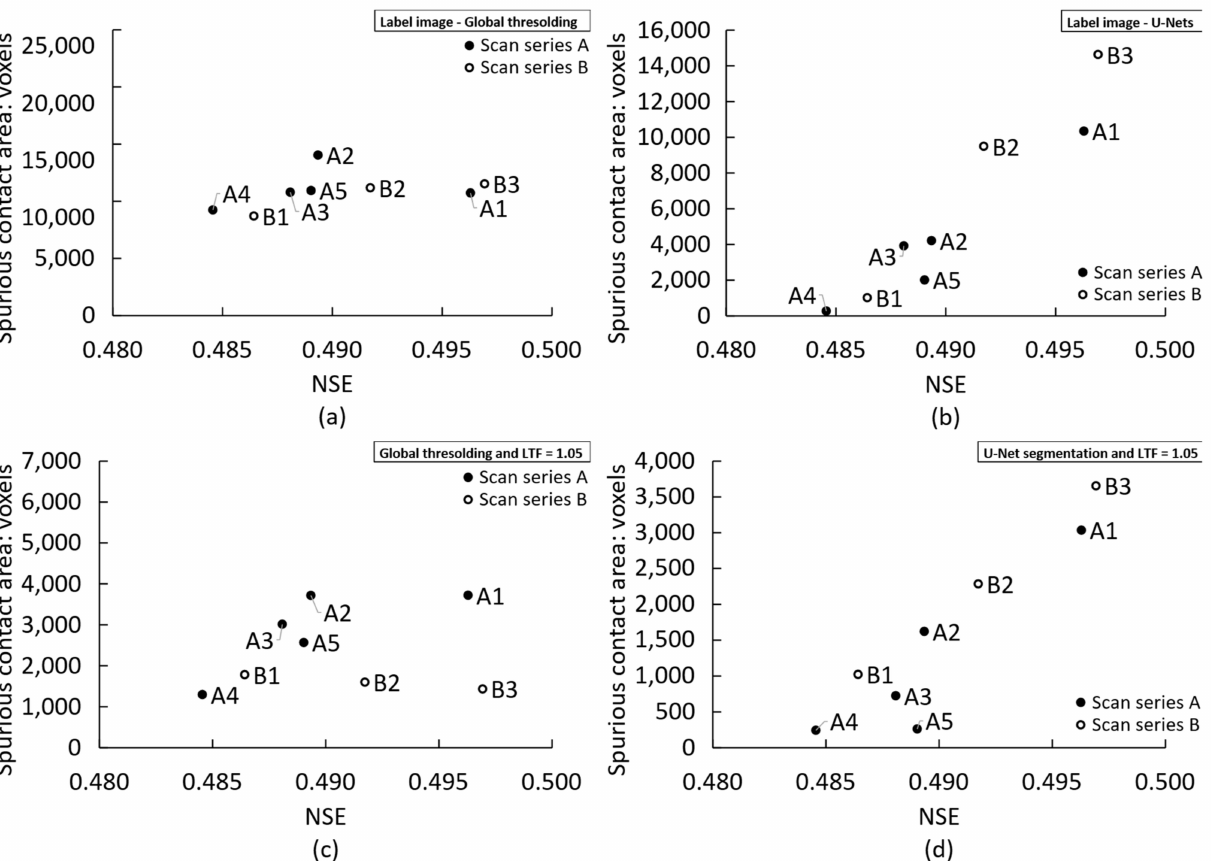
Figure 10. Correlation between spurious contact area and normalised Shannon entropy (NSE) using: ( a ) the global threshold label image; ( b ) the U-Net-derived label image; ( c ) the global threshold label image with local refinements using an LTF of 1.05; ( d ) the U-Net-derived label image with local refinements using an LTF of